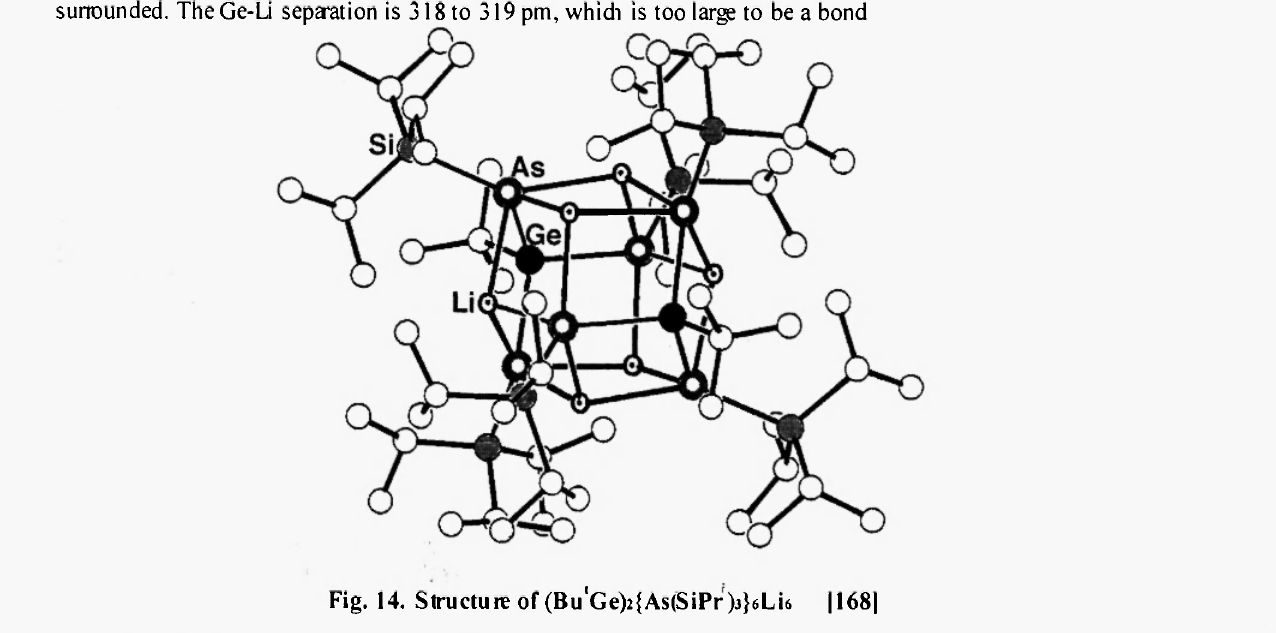
Fig. 14. Structure of ( B u ' G e ^ A s f S i P r ) ^ !^